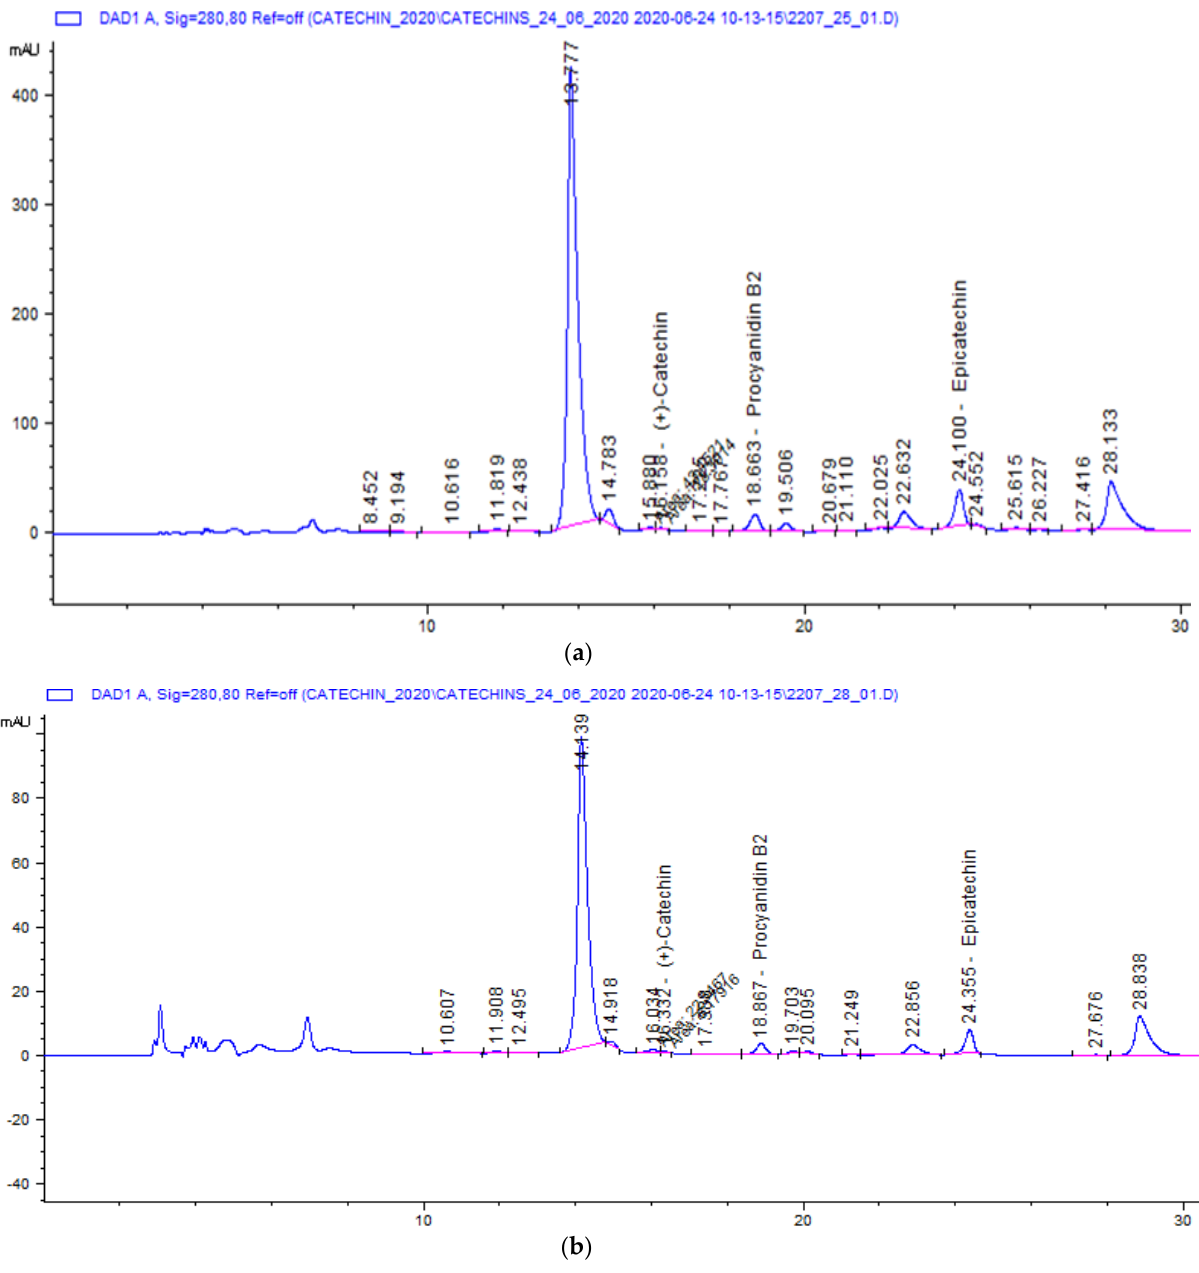
Figure 1. ( a ) Exemplary chromatogram profile of cocoa liquor from Peru. ( b ) Exemplary chromatogram profile of CMM (C503h).